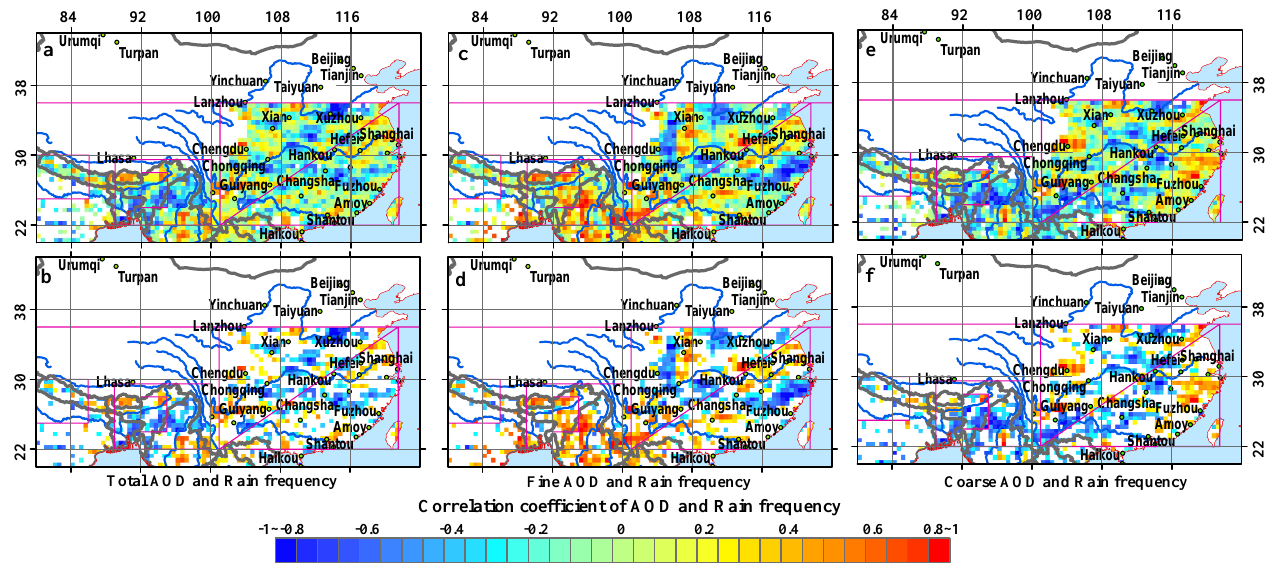
Fig. 7. The spatial distribution of correlation coefficient between rain frequency with AOD ( a, b with only significant correlation coefficients shown, a 75% confidence level was taken); Fine mode AOD ( c, d same with b ); coarse mode AOD ( e, f same with b ).